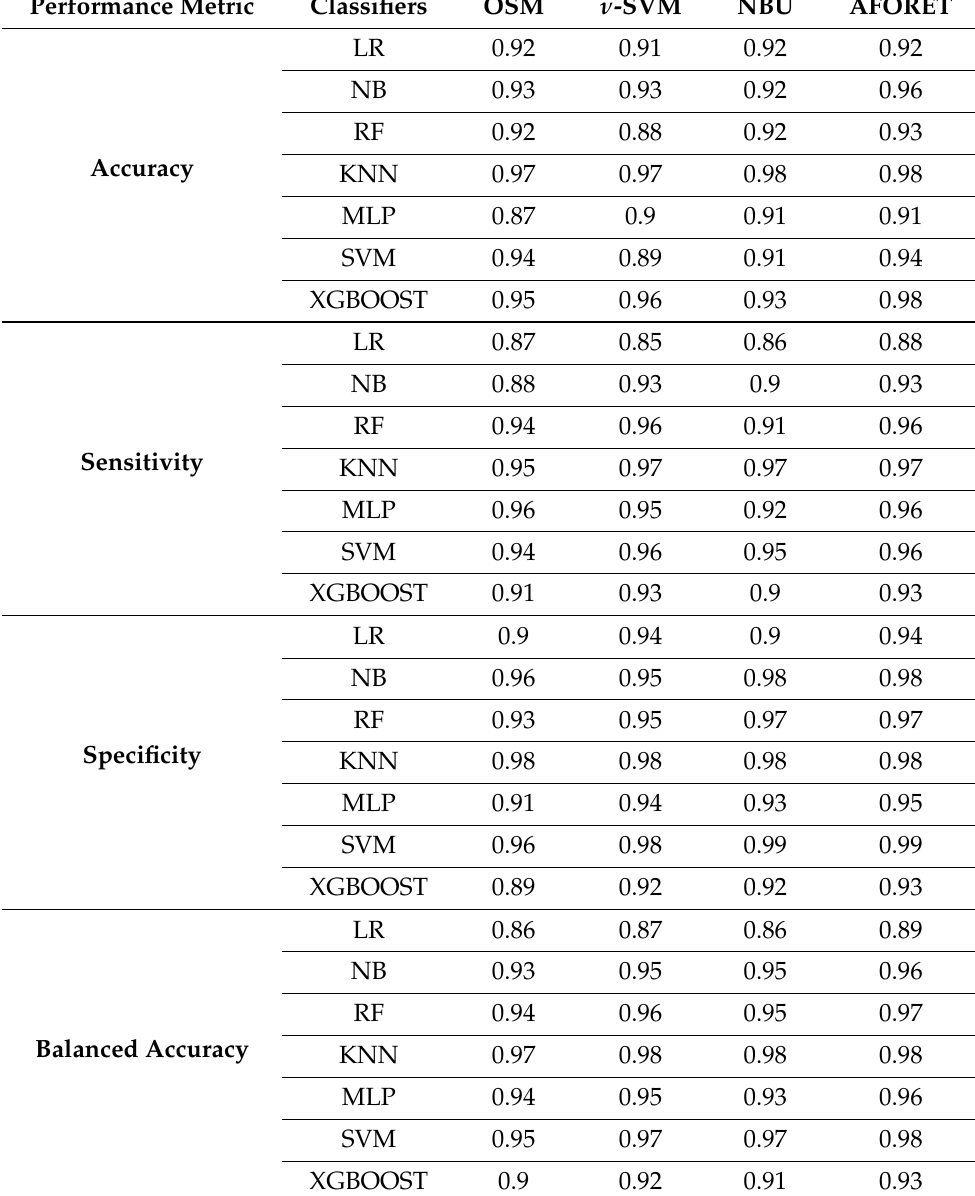
Table 9. Comparison of AFORET with OSM, NBU, and ν -SVM algorithms. Performance Metric Classifiers OSM ν